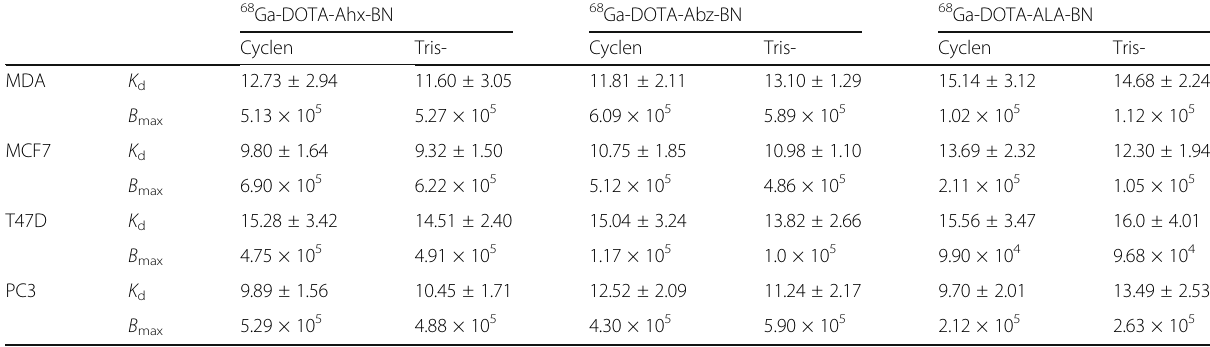
Table 2 In vitro tumor cell binding characteristics: determination of dissociation constants ( K d ) in nM and apparent number of binding sites per cell ( B max ) of the 68 Ga-labeled BN peptides ( n = 3-5 experiments; mean values ± SD; B max SD <